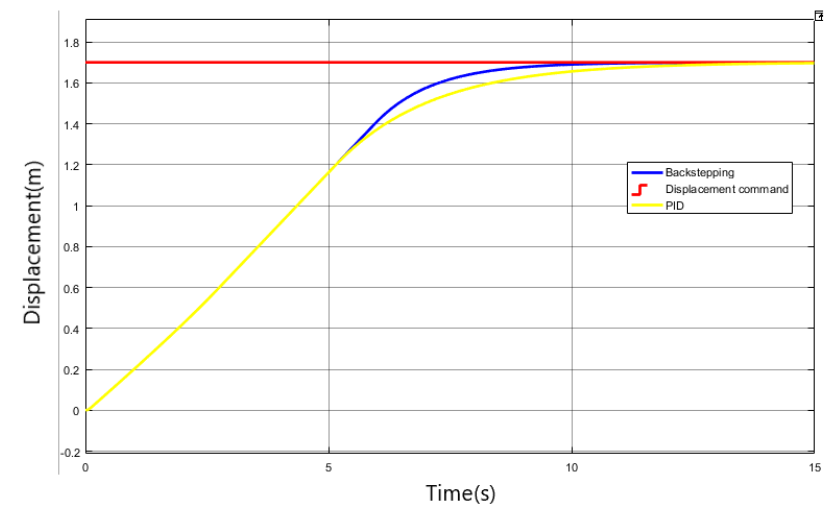
Figure 5. Comparison of displacement simulation between traditional PID and adaptive inversion controller.